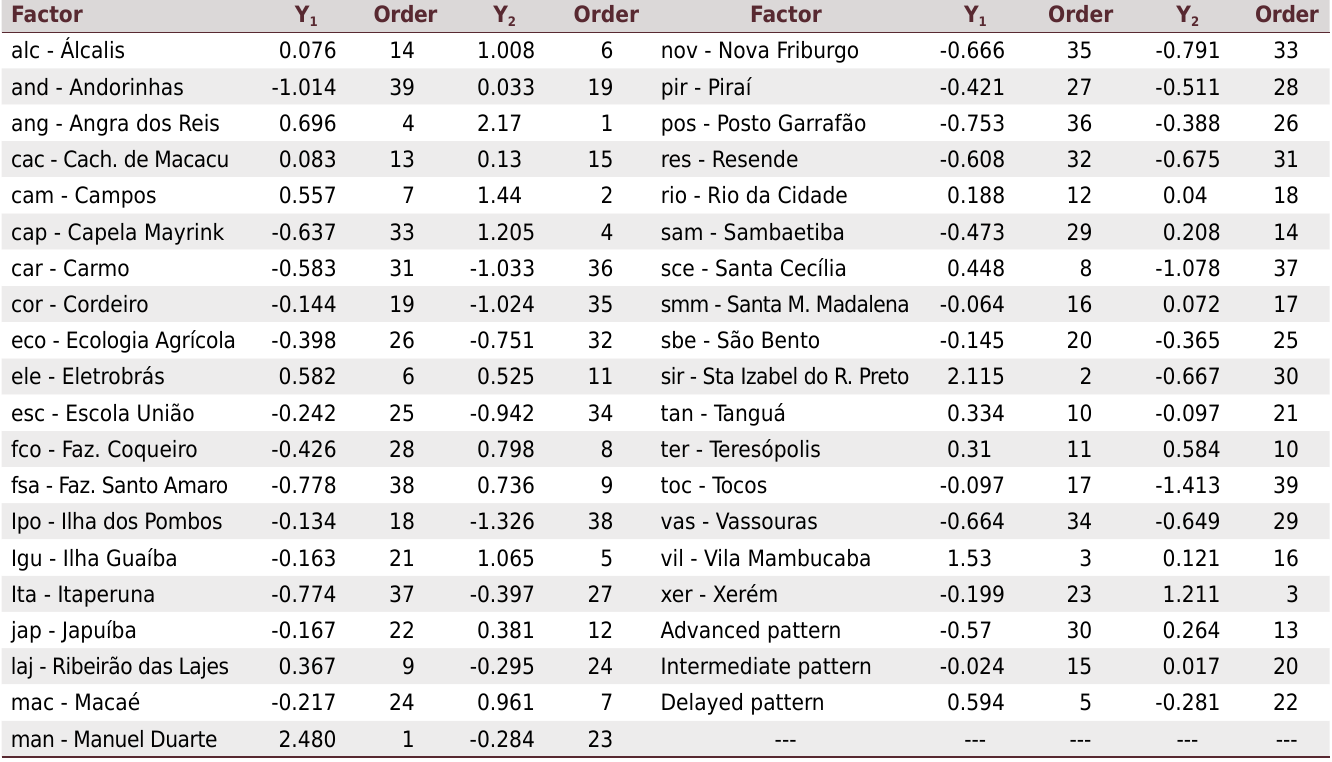
Table 2. Values of the principal components (Y 1 and Y 2 ) for the rainfall stations, rainfall patterns, and percent of information retained by them (% variance and % accumulated variance) Factor Y